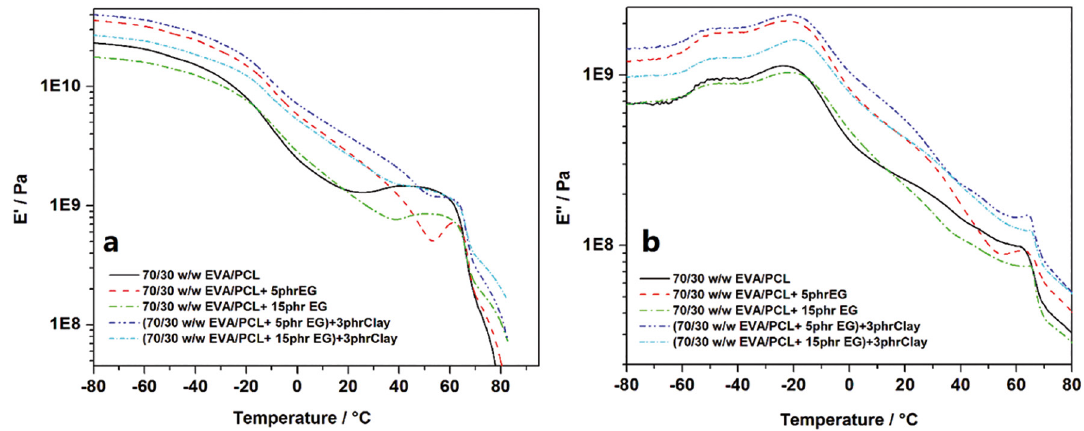
Figure 9: Storage and Loss modulus as function of temperature for EVA/PCL blend, EVA/PCL/EG and EVA/PCL/EG/Cloisite 15A